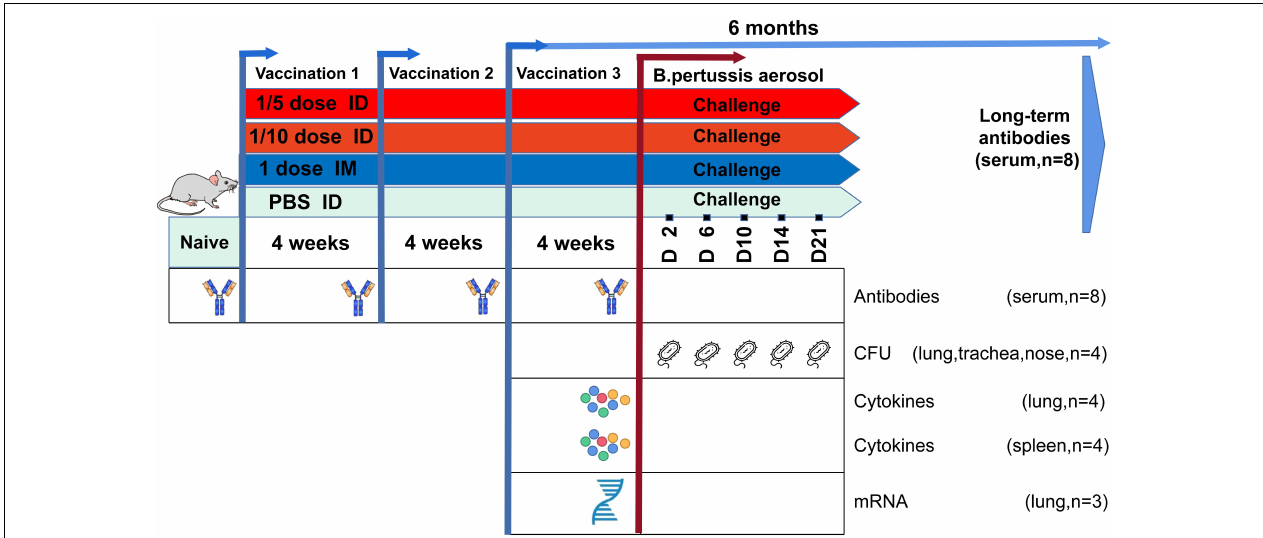
FIGURE 1 | Summary of the study design. Wistar rats were immunized with different doses of DTaP-sIPV by the intradermal (ID; red) or intramuscular (IM; blue) route every 4 weeks. Subsequently, for both routes the vaccination-induced responses were characterized over a period of immunization at four time points including 6 months after the end of immunization for long-term immune-protective observation. In addition, a B. pertussis challenge [10 11 colony-forming units (CFUs)] was performed on day 0 in all vaccinated groups and control rats (green). Vaccination responses were characterized at the transcriptomic, antibody, and cellular levels on given time points, as